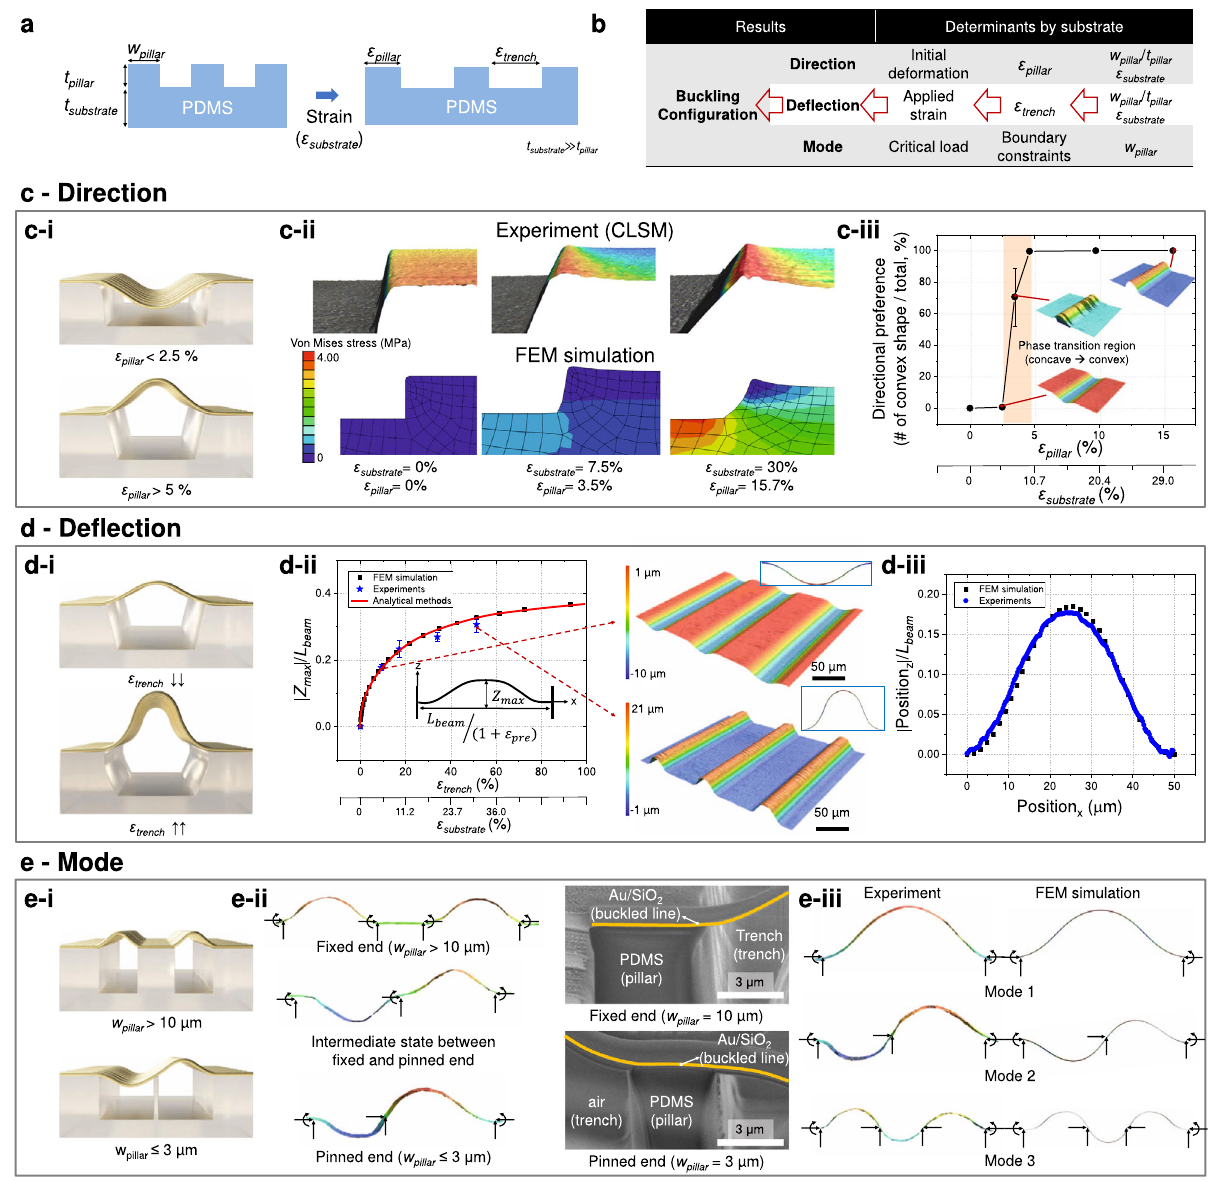
Fig. 3 | Design of buckling con fi guration and the related fabrication mechan- ism. a De fi nition of the design parameters of the substrate. b Determinants by substrate microstructure for controlling the three components of buckling con- fi guration(i.e.,direction,de fl ection,andmode). c